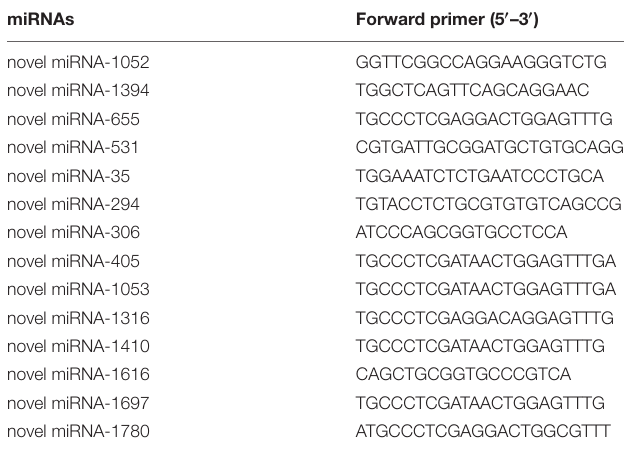
TABLE 1 | Primers of miRNAs used for the qPCR analysis.